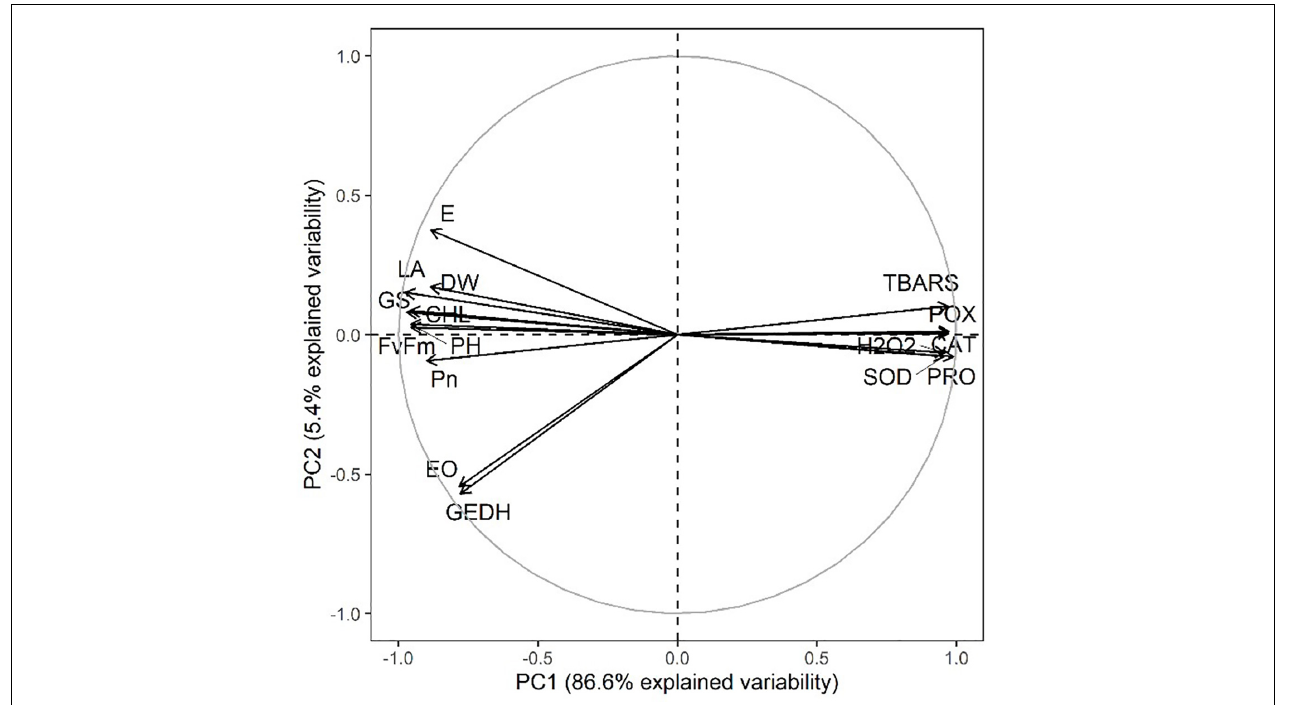
FIGURE 10 | PCA variables factor map of all tested parameters and all five treatments. DW, dry weight; PH, plant height; LA, leaf area; CHL, chlorophyll content; GS, stomatal conductance; E, transpiration rate; Pn, net photosynthetic rate; Fv/Fm, quantum yield; H 2 O 2 , hydrogen peroxide content; TBARS, thiobarbituric acid reactive substances content; CAT, catalase activity; POX, peroxidase activity; SOD, superoxide dismutase activity; PRO, proline content; GEDH, geraniol dehydrogenase activity; EO, essential oil content.